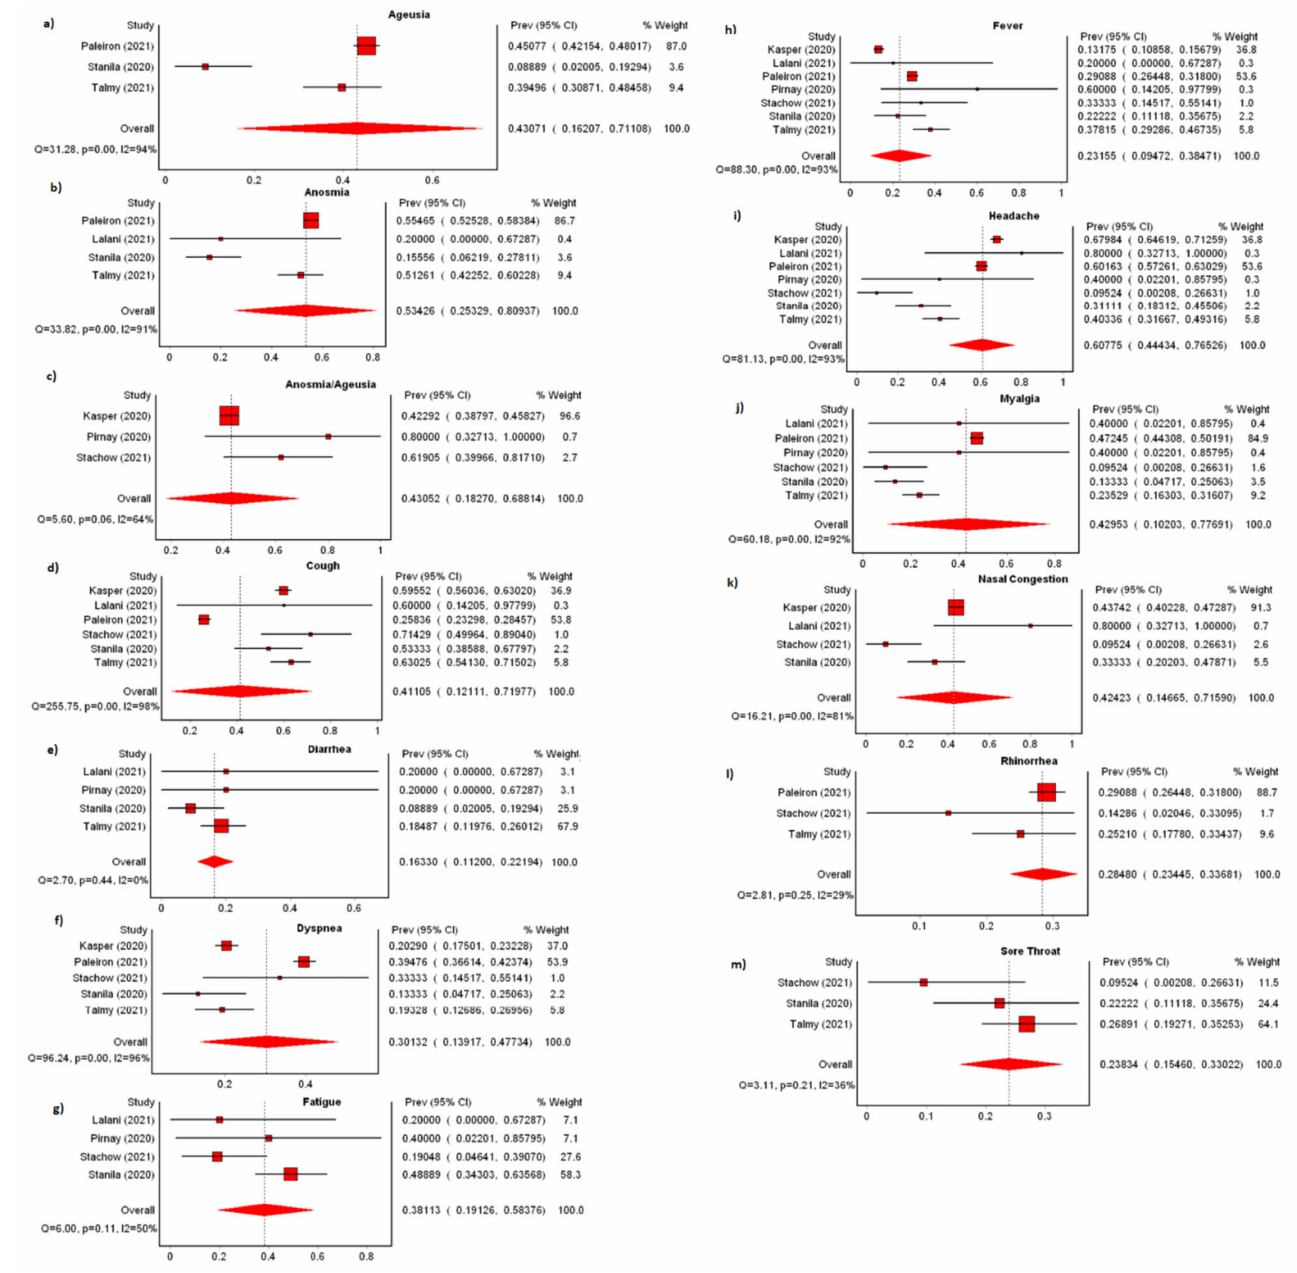
Figure 4. Meta-analyses of incidence ( a ) ageusia, ( b ) anosmia, ( c ) ageusia/anosmia, ( d ) cough, ( e ) diarrhea, ( f ) dyspnea, ( g ) fatigue, ( h ) fever, ( i ) headache, ( j ) myalgia, ( k ) nasal congestion, ( l ) rhinorrhea, ( m ) sore